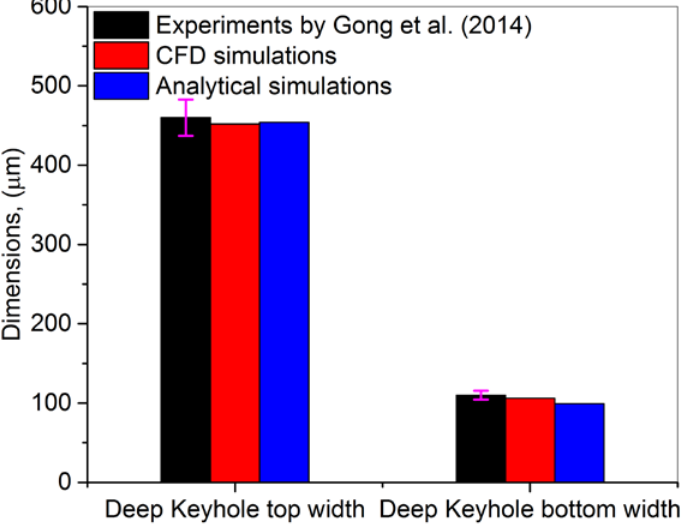
Figure 11. A comparison among experiments [49], CFD and analytical simulations for deep keyhole top width and bottom width.